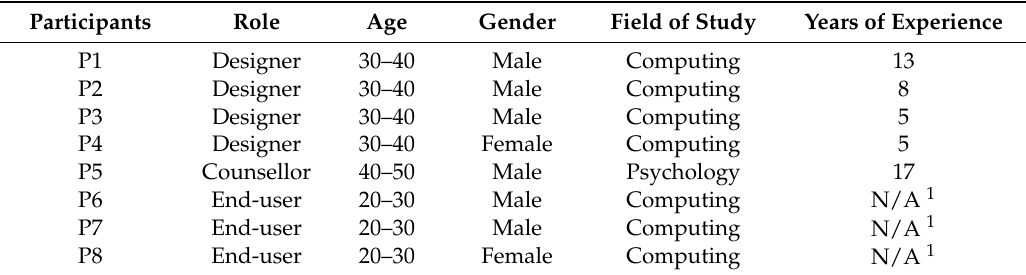
Table 1. The background of the participants.